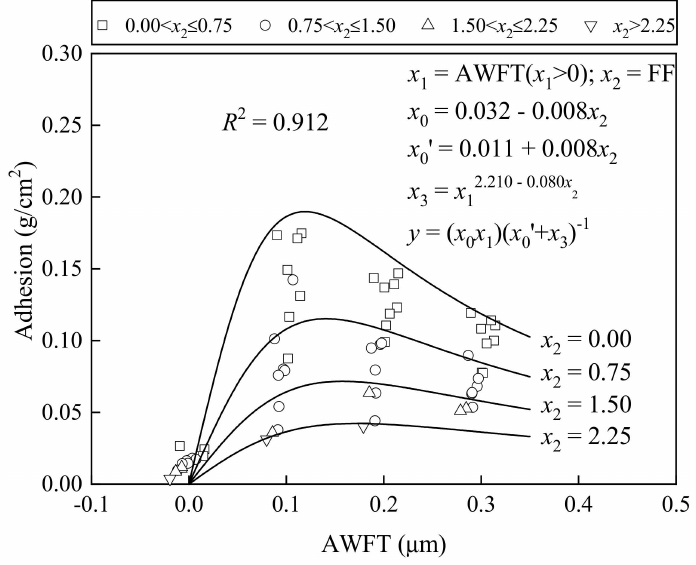
Figure 9. Correlation of adhesion with AWFT and